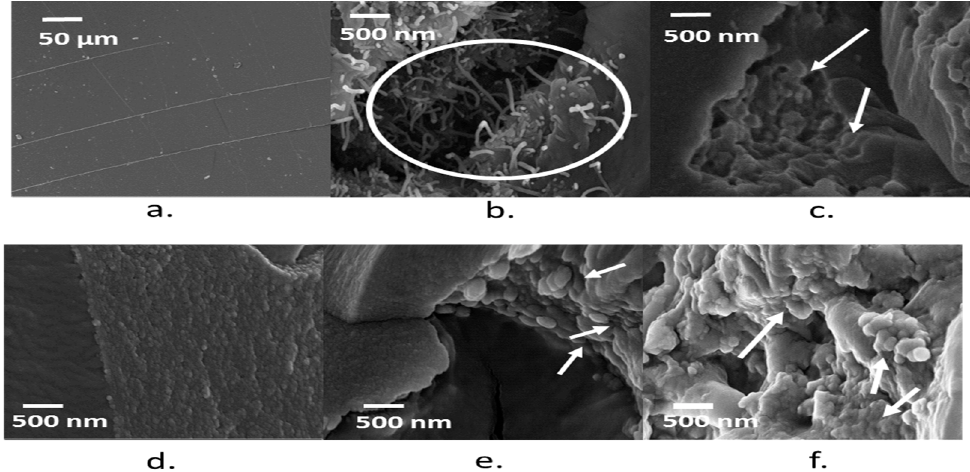
Figure 5. Morphology of neat epoxy ( a ) MWCNTs 1 wt %; ( b ) biochar 2 wt %; ( c ) biochar HT 2 wt %; ( d ) biochar 20 wt %; ( e ) biochar HT 20 wt %; ( f ) Composites. Arrows indicate phenomena of crack bridging and obstruction by the various fillers used.